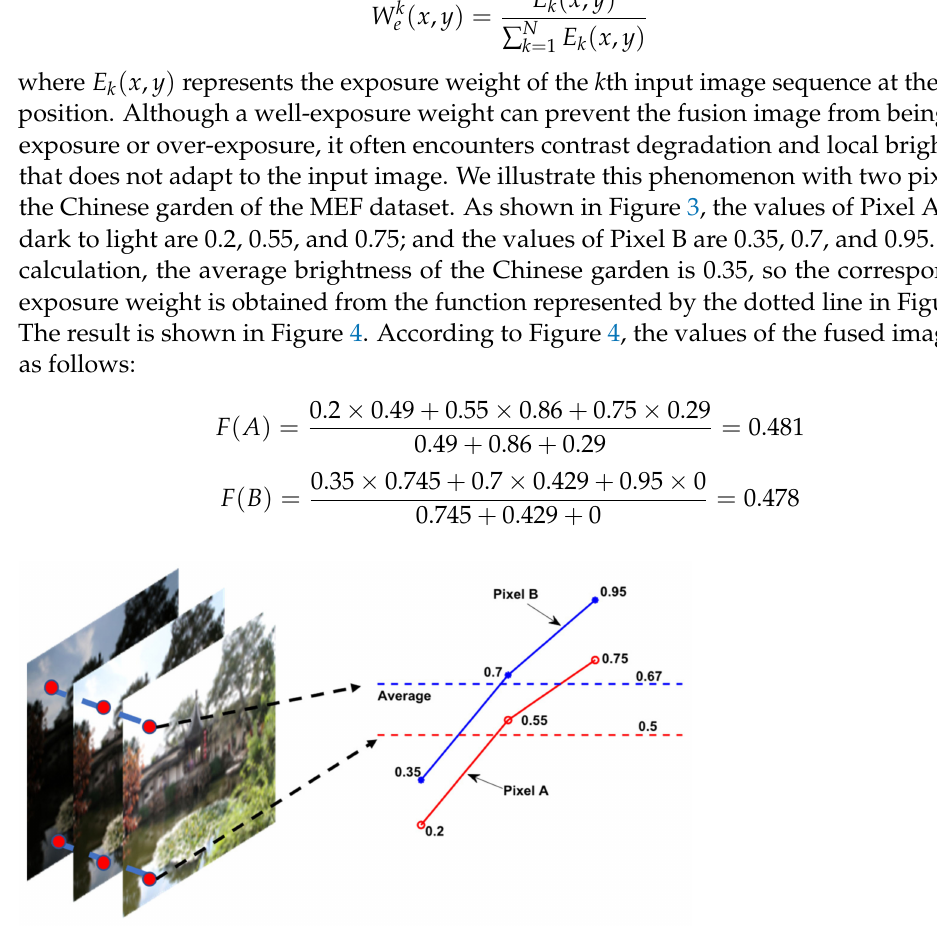
Figure 3. Two groups of pixel parameters of Chinese Garden.